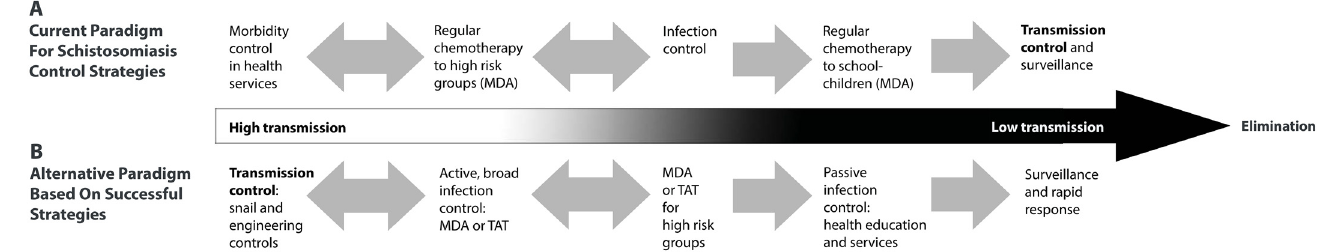
Fig 2. Strategy details for schistosomiasis control: the current paradigm and an alternative based on past successes. (A) The current paradigm for global schistosomiasis control, adapted from [30], and (B) an alternative strategy based on historical successes (this paper). MDA = mass drug administration, TAT = targeted ( “ test-and-treat ” )